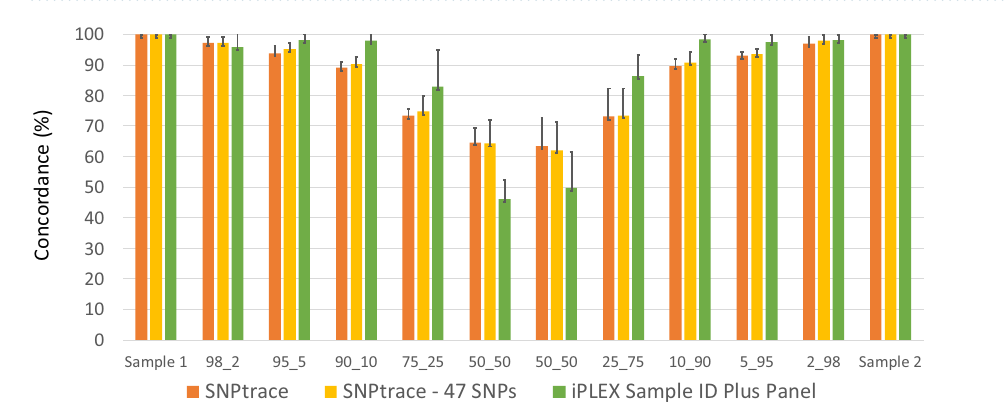
Figure 3. Average concordance (%) of the the SNPtrace panel (96 SNPs), SNPtrace panel (47 SNPs) and the iPLEX Sample ID Plus panel across the different sample mixes. Error bars indicate standard